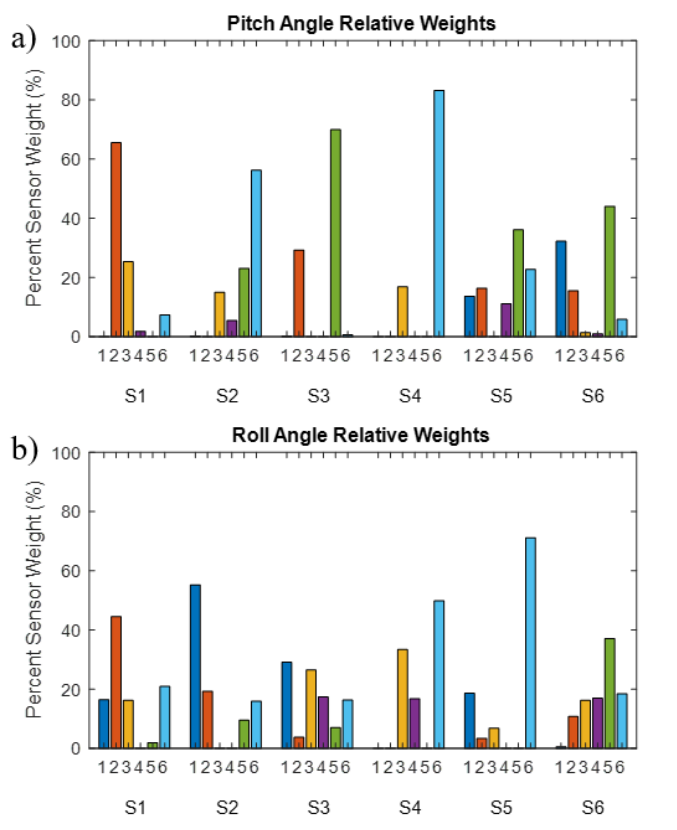
Figure 6. Sensor weights for determining the pitch ( a ) and roll ( b ) angles from the weighted average equation. Values are separated by subject number and sensor number. Locations of the sensors are as followed: 1. right chest; 2. left chest; 3. right front abdomen; 4. left front abdomen; 5. right back abdomen; and 6. left back abdomen. These weights resulted from the motion capture calibration